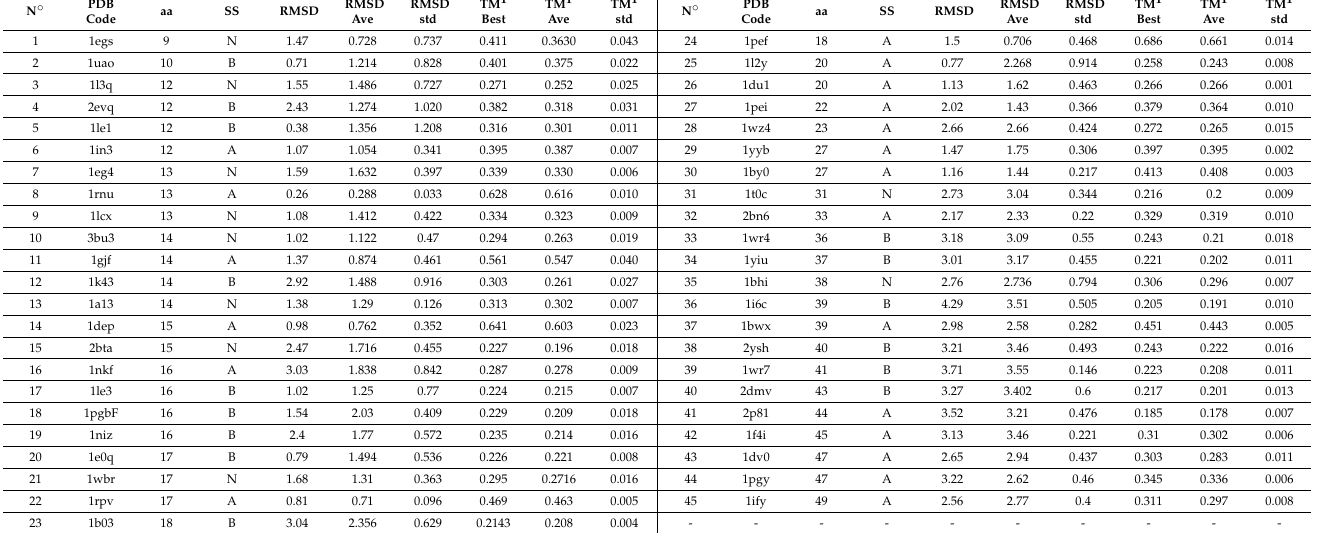
Table 2. Results obtained by GRSA2-SSP.